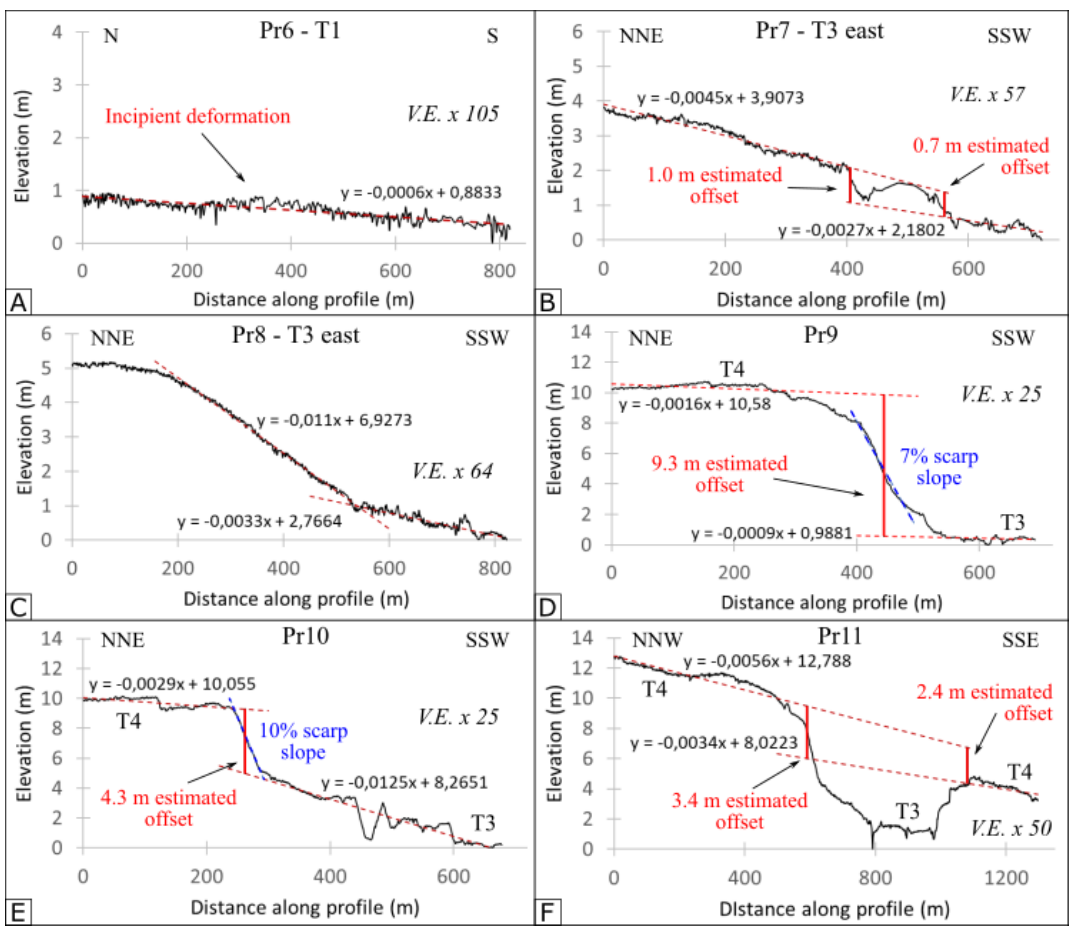
Figure 9. Topographic profiles from the DEM, drawn through the WNW–ESE striking scarp on different terraces (see Figure 7 for location of the red profiles). The black arrows indicate the locations of the maximum vertical offsets. The offset estimates are displayed by red vertical segments. The red dashed lines indicate the slope trends of the terrace surfaces. Relative elevations are plotted on the y-axis. ( A ): The topographic profile along the T1 riverbed surface shows a bulge which deviates from the main slope trend. ( B ): Topographic profile along the terrace T3 on the eastern side of the river. The warped feature around 450 m and 600 m is probably related to industrial buildings crossed by the profile. ( C ): Topographic profile along terrace T3, almost 100 m east of Pr7. Pr8 is drawn along a road of the village. Therefore, the scarp is smoothed out. ( D ): Topographic profile from central T4 to eastern T3 passing through the scarp. The blue dashed line represents the slope trend of the scarp. The offset estimate is located at the steepest point. ( E ): Topographic profile drawn parallel to Pr9, ca. 200 m further east. ( F ): Topographic profile through the central and southern T4 surfaces. The offsets were estimated at the projected contact of the two terrace remains. The topographic trough between 600 and 1000 m results from erosion and deposition of terrace